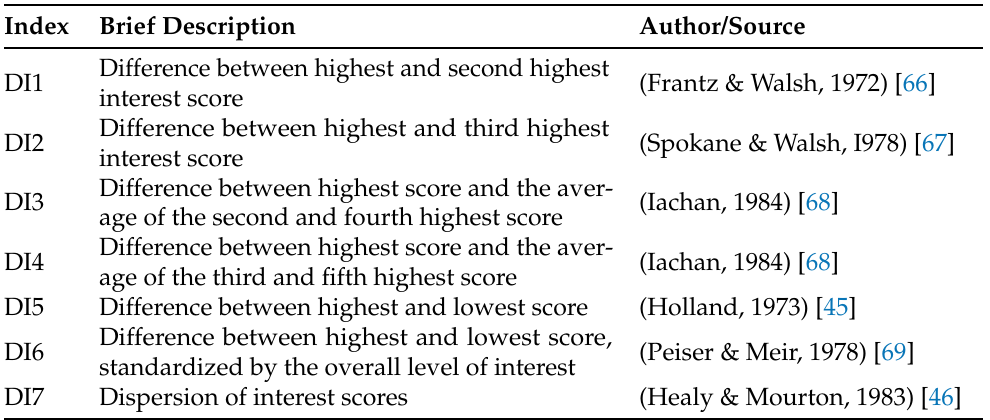
Table 3. Differentiation indices for Holland profiles implemented in the R -package holland as cited in ([7], p.